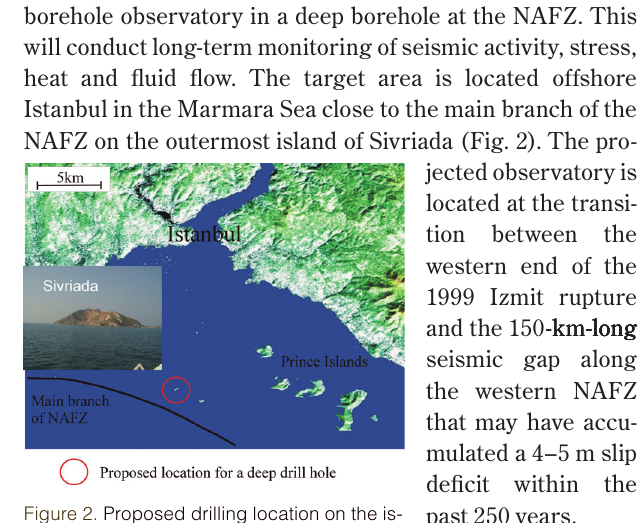
past 250 years. Figure 1. Google Earth view of the Marmara Sea / Istanbul region. Red